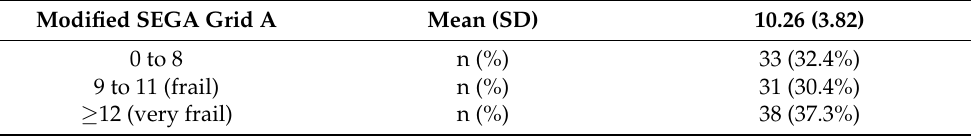
Table 6. Frailty according to modified Short Emergency Geriatric Assessment (SEGA) grid A (n =